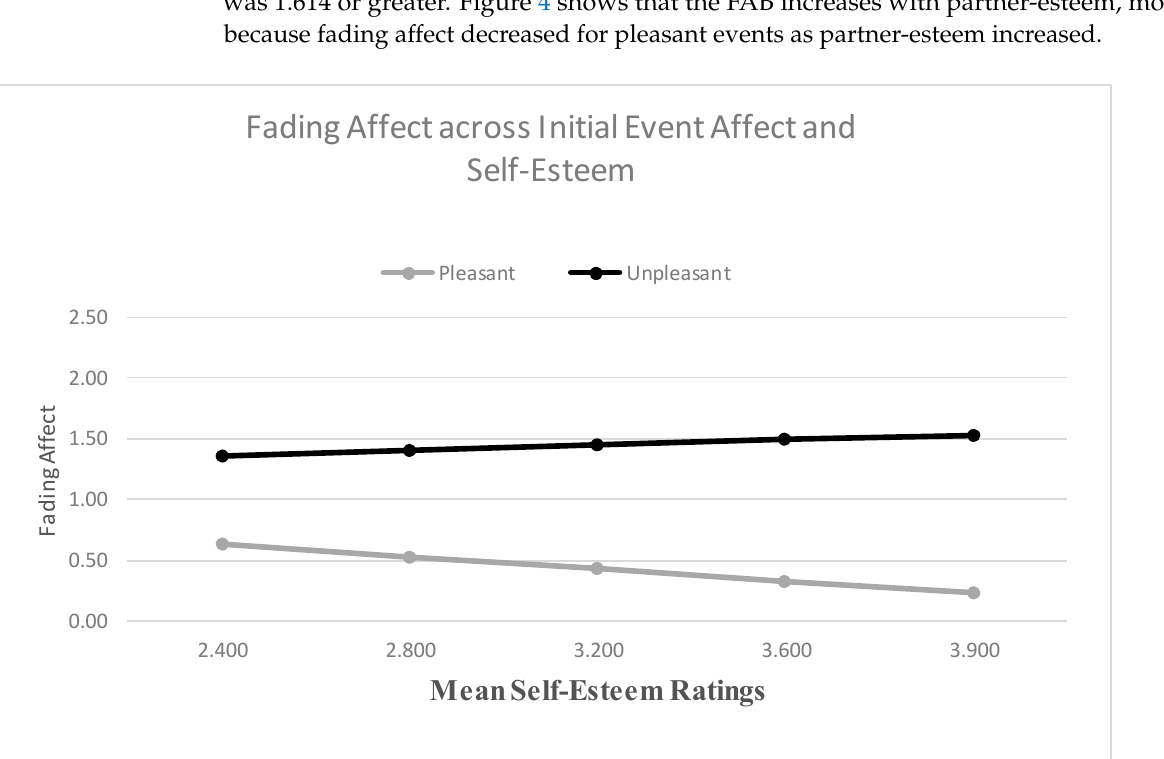
0.000.501.001.502.002.50 Figure 3. Fading affect for pleasant and unpleasant events across quintile levels (10th through 90th) of self ‐ esteem. Figure 4. Fading affect for pleasant and unpleasant events across quintile levels (10th through 90th) of partner ‐ esteem. When examining relationship satisfaction as a predictor, the main effects for both initial event affect and relationship satisfaction were significant, and the results from the